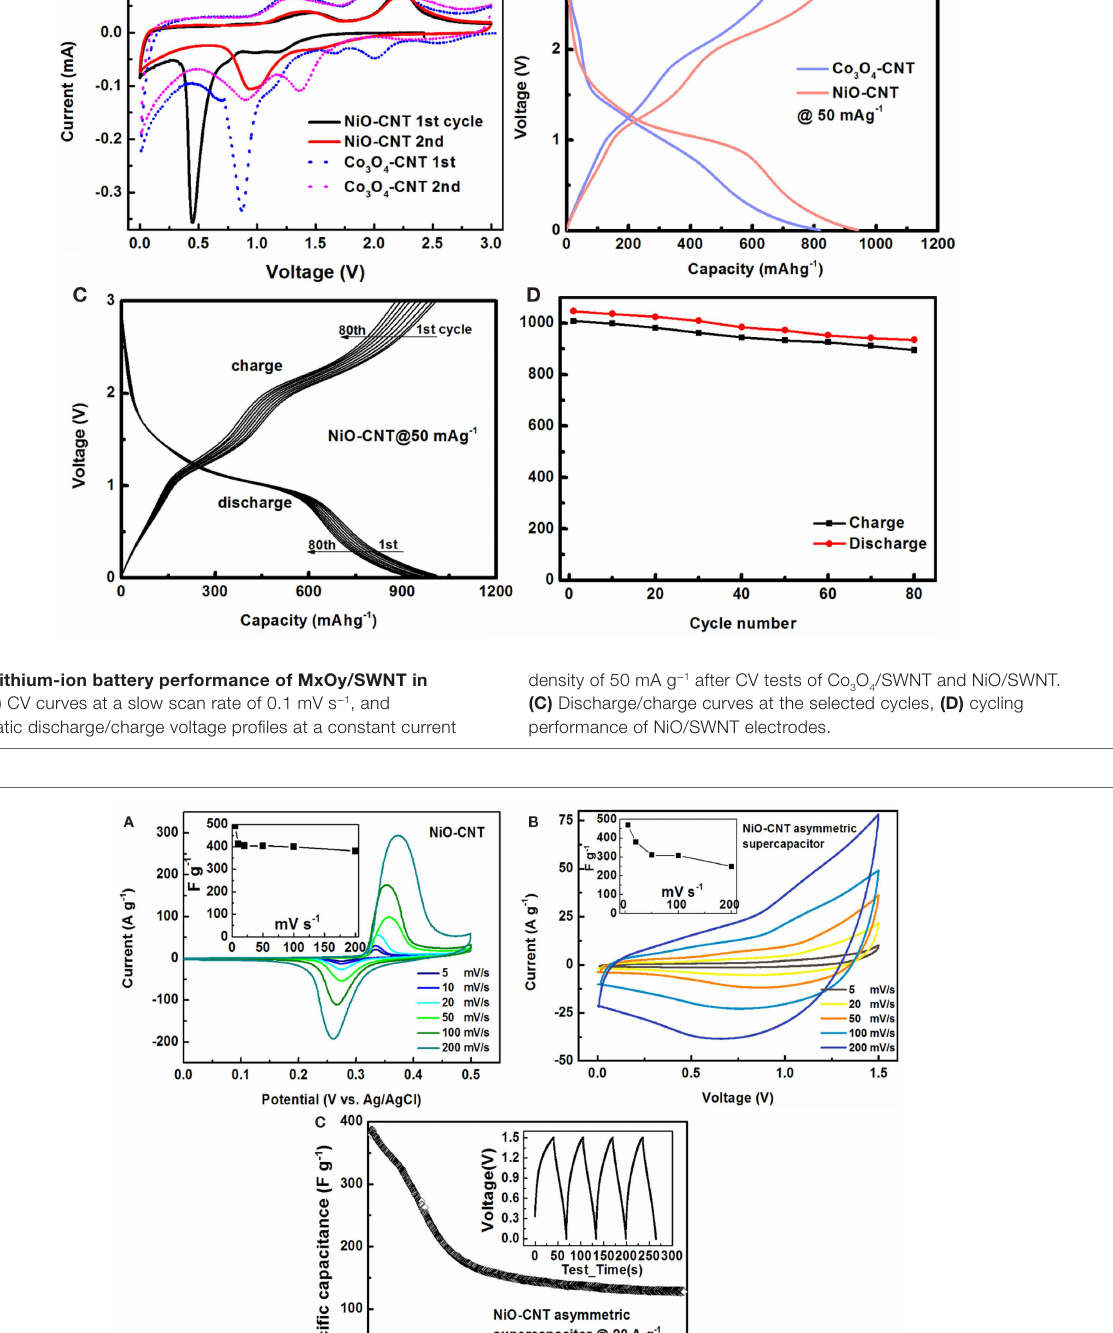
Figure 4 | (a) CV curves of NiO/SWNT at various scan rates. Inset: specific capacitance as a function of the scan rates calculated from CV. (B) CV curves of an asymmetric supercapacitor composed of ( + ) NiO/ SWNT-SWNT ( − ) at different scan rates between 5 and 200 mV s − 1 . Inset: